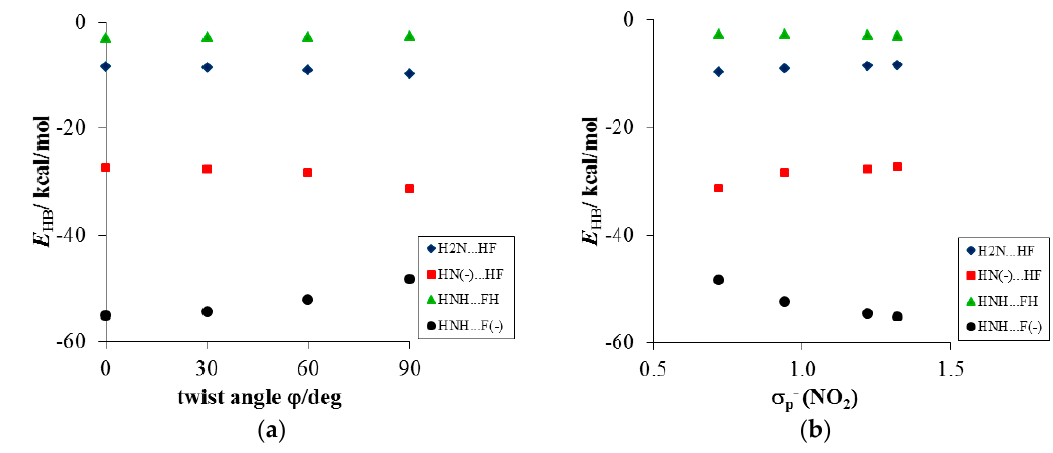
Figure 12. Dependences of H-bond energy, E HB , on ( a ) rotation of NO 2 group and ( b ) its σ p − constants [7] (for equilibrium complexes, except for HNH···F − interactions).